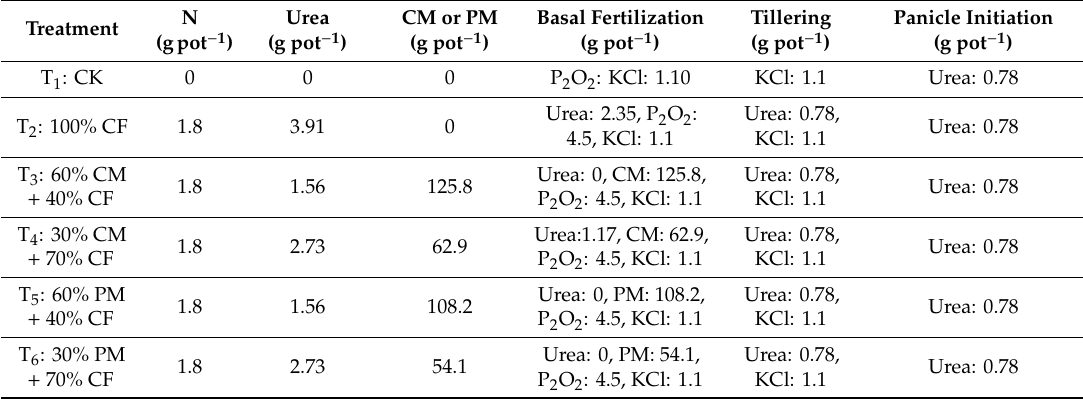
Table 3. Nutrient content and amount provided for each treatment and application